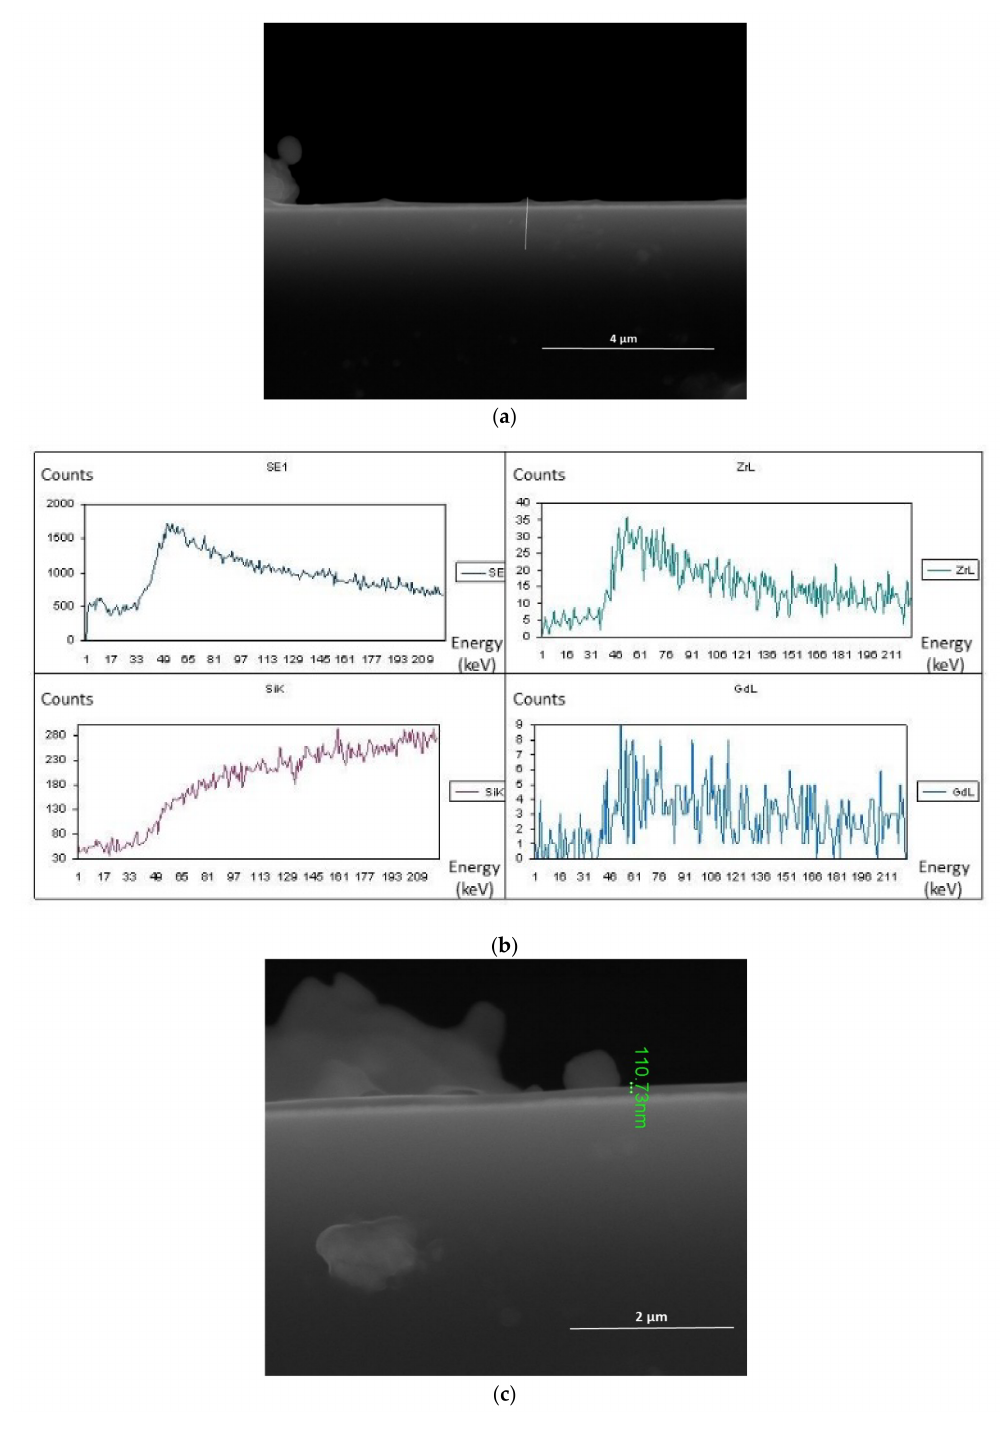
Figure 7. ZrO 2 -Gd 2 O 3 layer deposited at 700 ◦ C ( a ) and its cross-section ( c ) with linear EDS analysis ( b ). Molar content of Gd(tmhd) 3 in the gas reaction mixture: 20%. Synthesis time: 15